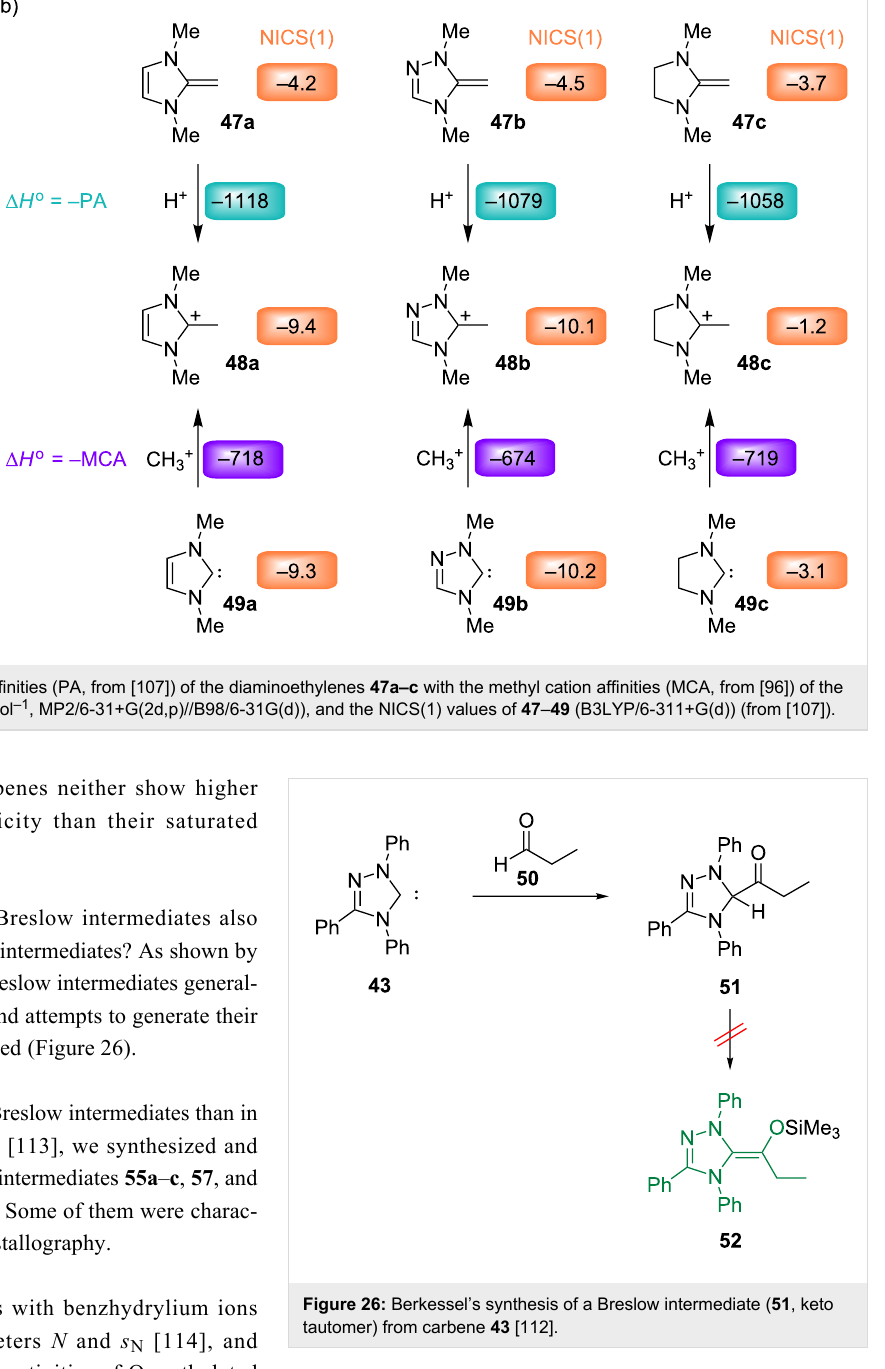
the +M-effect of the methoxy group, which raises the HOMO of the reactants. Replacement of the sulfur atom in the benzothia- zole by a NCH 3 group ( 55b → 55c ) shows that imidazole derivatives are approximately four orders of magnitude more reactive than structurally analogous thiazole derivatives, which can, again, be assigned to the different electronegativities of sulfur and